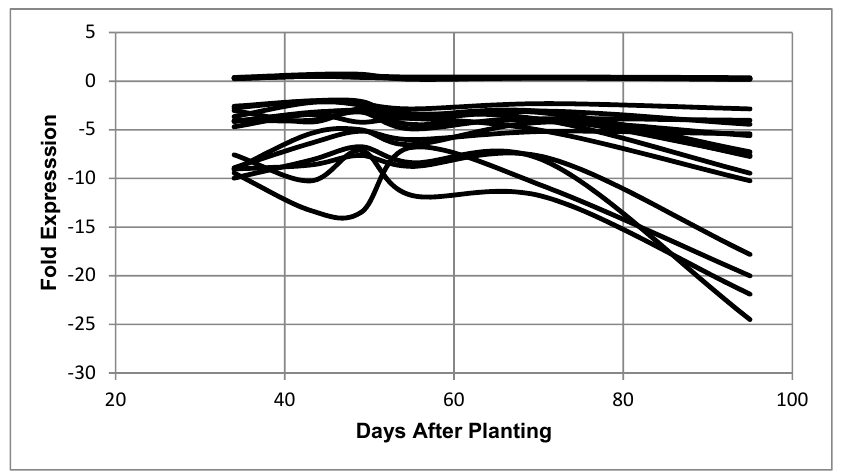
Figure 5. Expression of B . diazoefficiens bacteroid 30S ribosomal proteins as a function of days after planting. Fold expression value of 30S ribosomal proteins at 95 days after planting: S16 (0.36), S2 (0.29), S20 (0.27), S4 (0.20), S13 (0.19), S12 ( − 2.85), S19 (4.02), S6 ( − 4.43), S8 ( − 5.41), S14 ( − 5.60), S18 ( − 7.27), S7 ( − 7.61), S11 ( − 7.74), S1 ( − 9.46), S15 ( − 10.24), S3 ( − 17.81), S21 ( − 20.02), S10 ( − 21.90), and S17